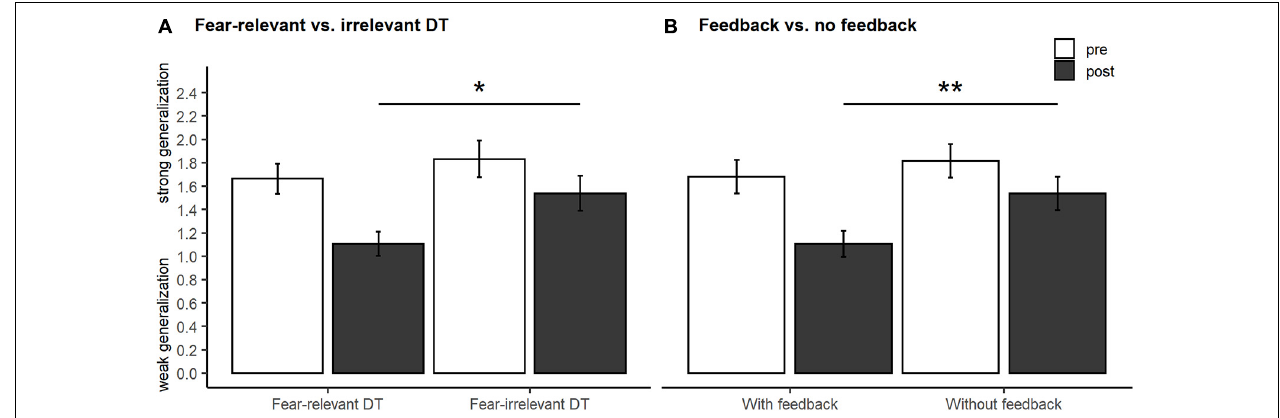
FIGURE 4 | Generalization indices (GI) for unconditioned stimulus expectancy ratings for generalization pre- and post-training averaged by factor fear relevance (A) or feedback (B) . Bar plots (with means and standard errors) of GI show less fear generalization post-training in the fear-relevant vs. fear-irrelevant discrimination training groups (A) and in the groups with vs. without feedback (fb, B ). The significance symbols indicate the main effects of ANCOVA. * p < 0.05, ** p < 0.01.